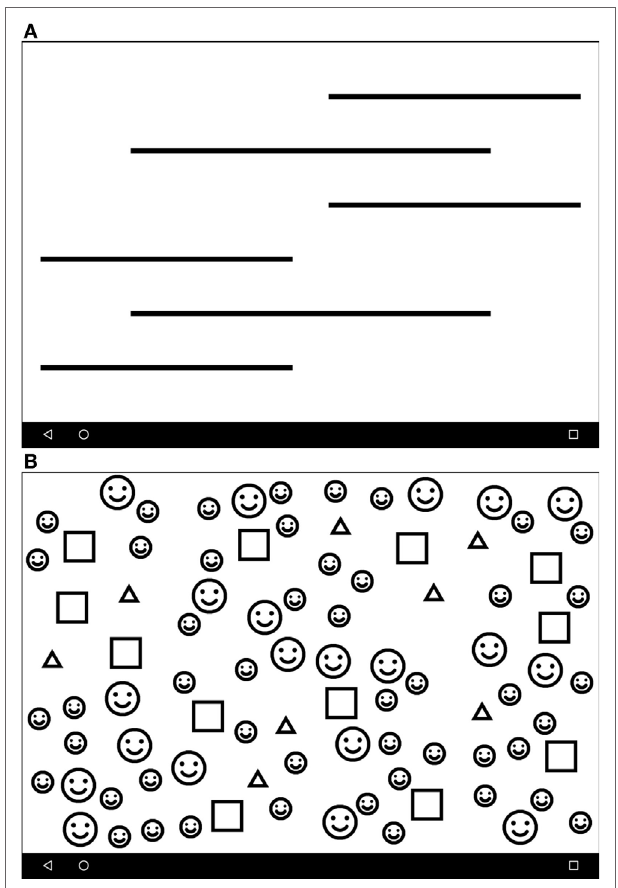
FigUrE 3 | (a) The Line Crossing test screen. Line thickness is calibrated against the acuity score to allow testing in low-vision patients. The patient is asked to press the perceived center of each line. (B) The Face Cancelation Test. A second test of inattention, whereby the patient is asked to press the small faces. As previous, line thickness is calibrated to acuity score.